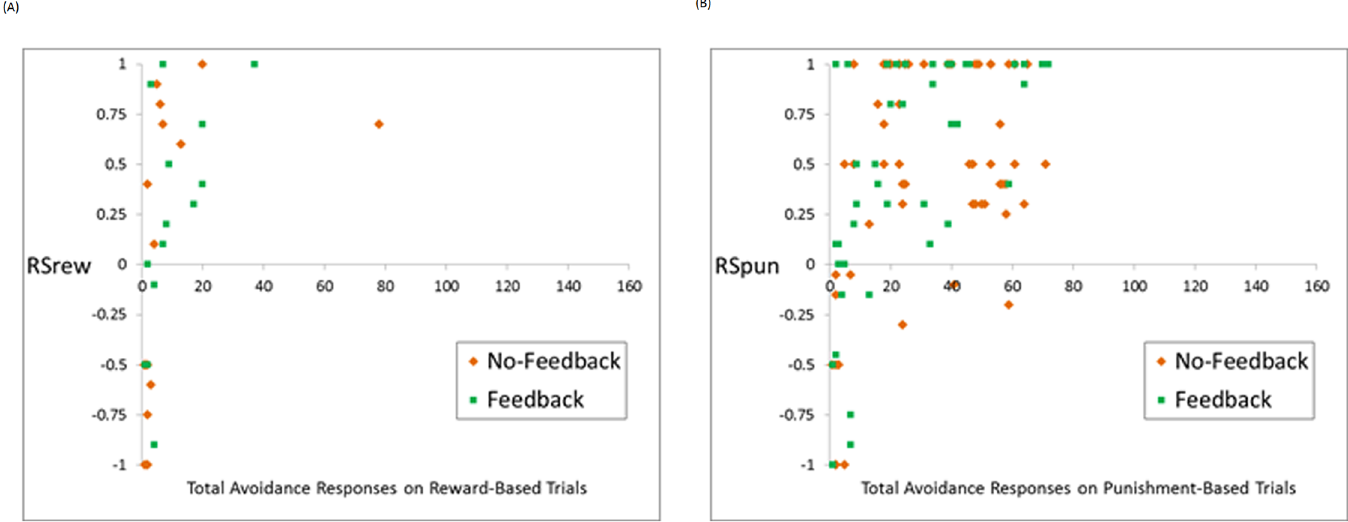
Fig 7. Correlations between avoidance behavior and estimated parameter values (A) RSrew and (B) RSpun , for subjects who made at least one avoidance response to the corresponding trial type, and whom these parameters therefore had defined values. Both RSrew and RSpun were positively correlated with avoidance responses on the corresponding trial types, indicating that subjects who made more avoidance responses tended to more positively value the resulting feedback.